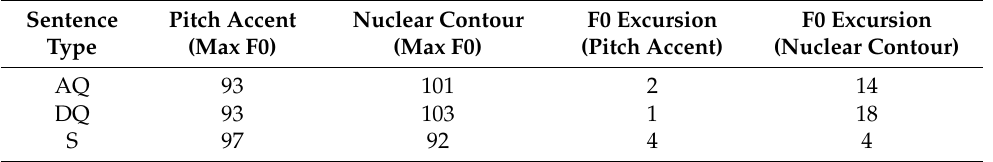
Table 4. Perception stimuli used in the C task. Mean max F0 values in the first pitch accent and the nuclear contour, and F0 excursion in the first pitch accent and nuclear contour (values in